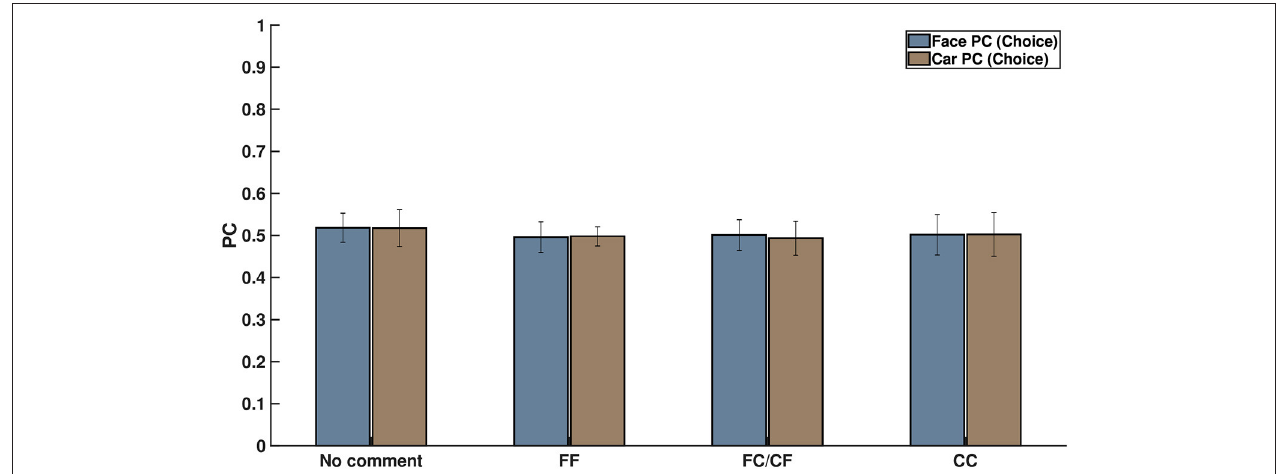
FIGURE 6 | Percentage of correctly classified face and car decisions for the four kinds of comments shown on screen on the basis of their neural signals after cue exposure. This clearly shows that subject choice did not arise from cue-related expectation bias.